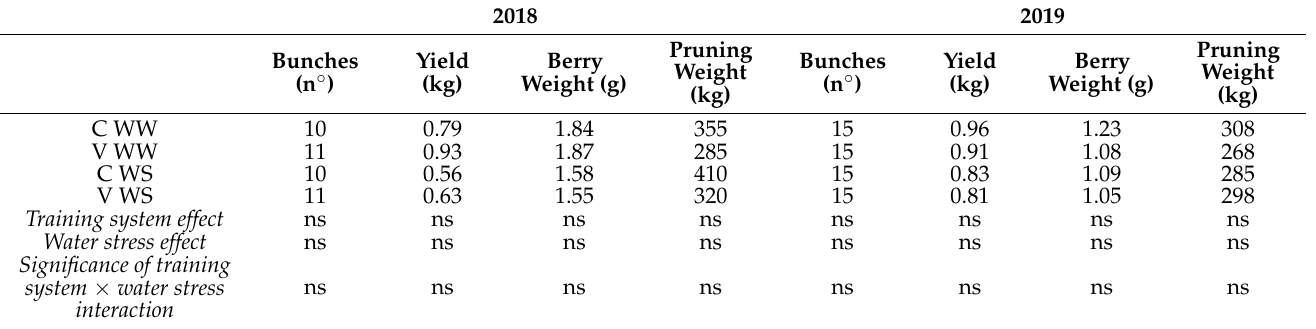
Table 6. Yield data and pruning weight at harvest. Data are collected in 2018 and 2019 seasons. Values represent means of 4 replicates: C WW= well-watered vertical shoot-positioned canopy, V WW = well-watered V-shaped open canopy, C WS = vertical shoot-positioned canopy with water restriction, V WS = V-shaped open canopy with water restriction. Significant differences are indicated: ns, not significant. Mean values were separated within each column with different letters using the Tukey test.